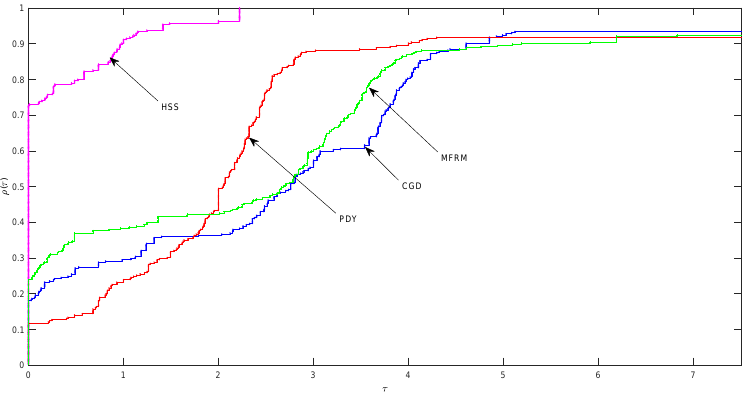
Figure 2. Dolan and Moré performance profile with respect to number of function